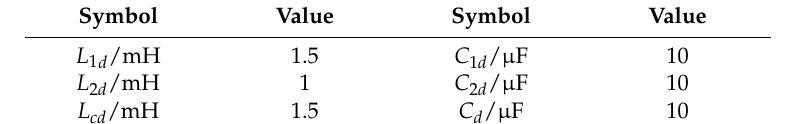
Table 3. Parameters of virtual impedance.